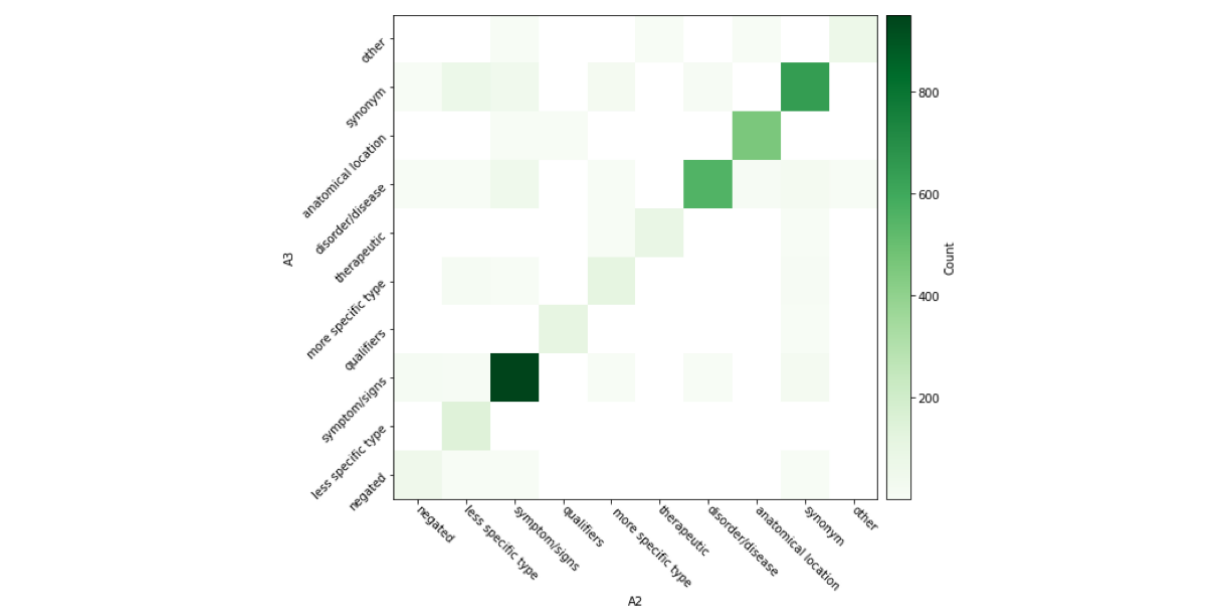
Figure 3. A2/A3 interannotator agreement of returned terms according to semantic